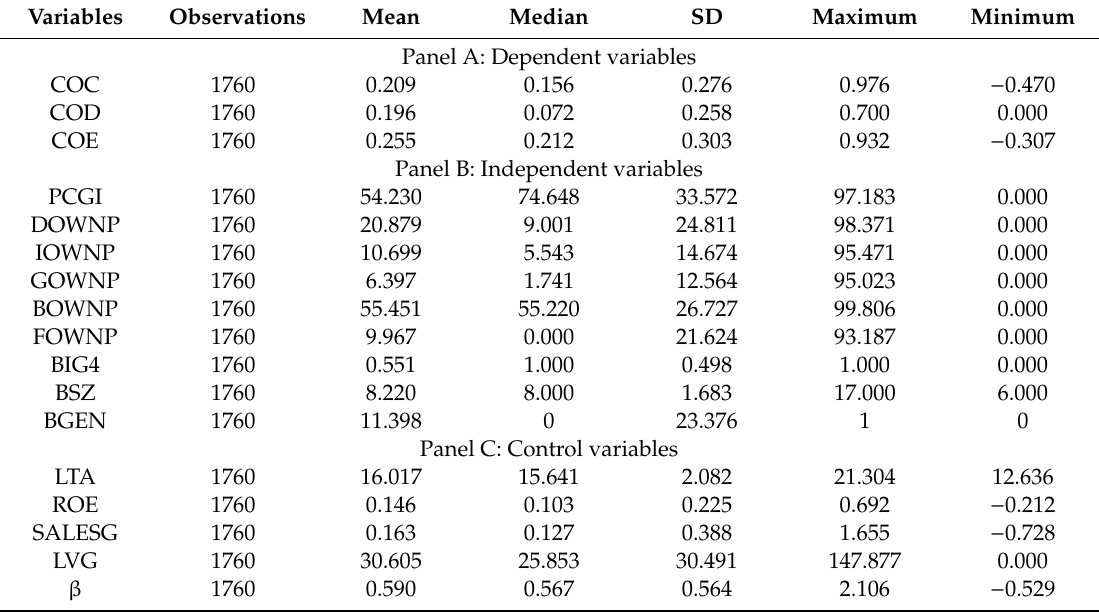
Table 1. Summary